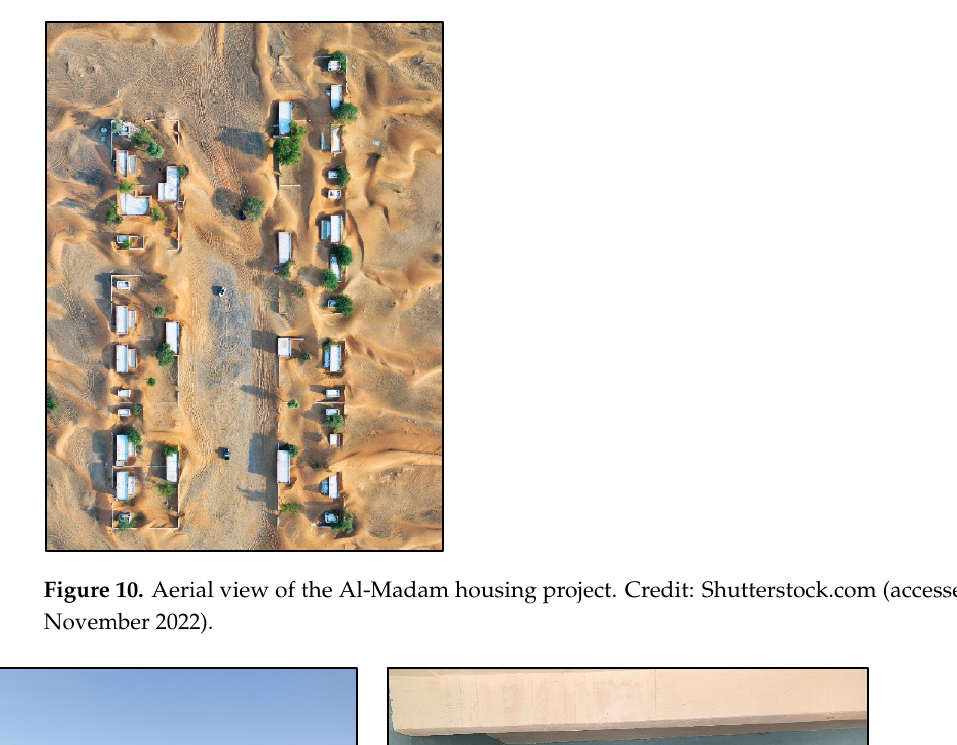
Figure 9. Location of Al ‐ Madam town, UAE. Google maps. Accessed on 15 October 2022.